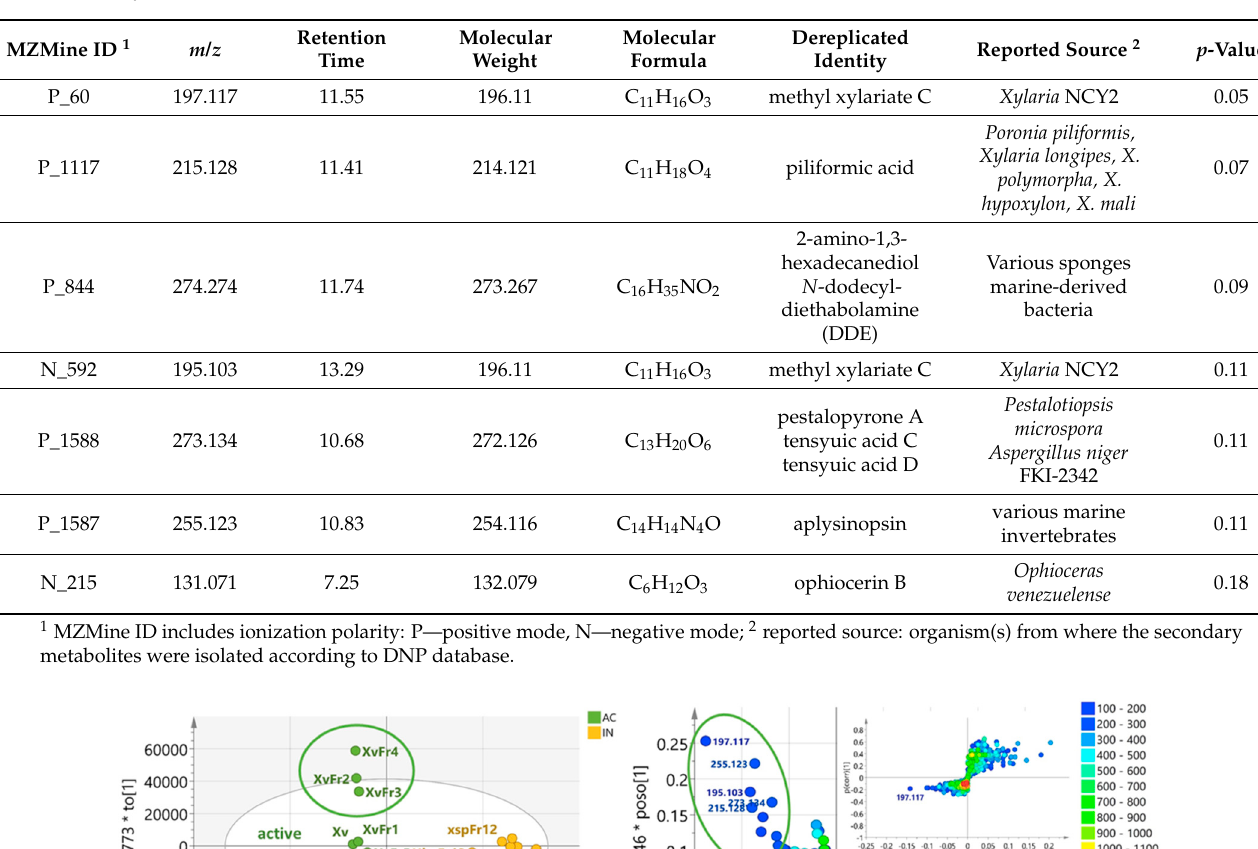
Table 3. Discriminating secondary metabolites for ion peaks of X. venustula MH370742 putatively dereplicated from Dictionary of Natural Products (DNP) database.